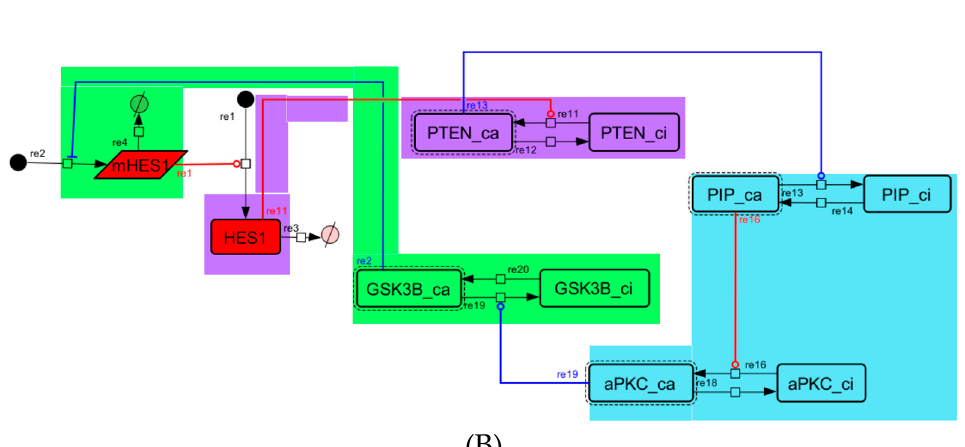
Figure A6. Diagram of negative-feedback loop between beta-catenin and HES1. ( A ) The negative-feedback loop in the whole signaling network. ( B ) The contracted negative-feedback loop in the toy model. Red edges represent positive regulations. Blue edges represent negative regulations. Background colors show correspondence relationships between before and after contraction.